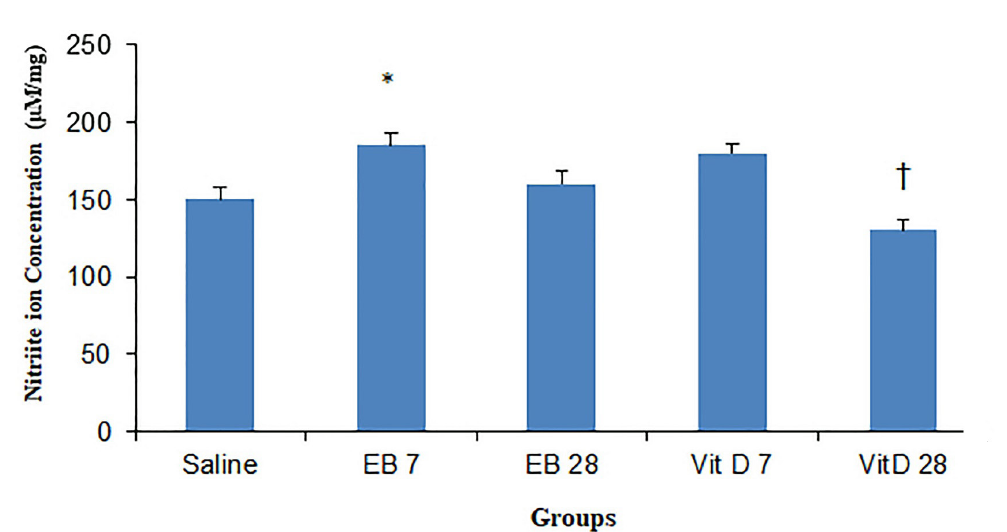
FIGURE 3 - Measurement of nitrite ion concentration in homogenate of the hippocampus of rats after MWM experiments (µmol per mg of protein). Significant difference between group of D28 compared to EB7 group. Each data is average of 10 experiments and bars represent standard errors. *†: p < 0.05 significant difference between EB7 and vitamin D28